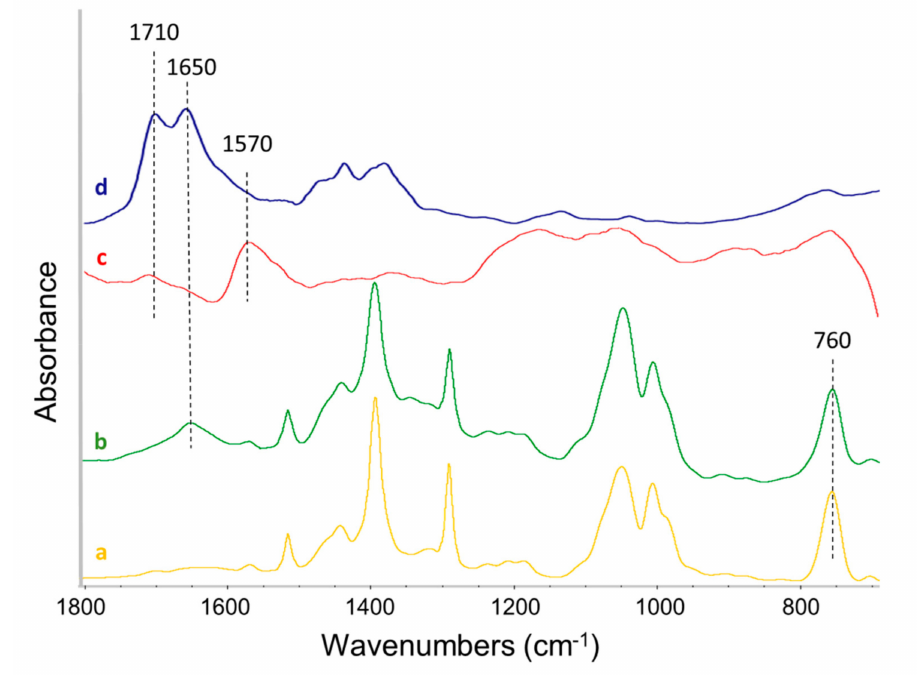
Figure 7. FT-IR spectra of: ( a ) SP, ( b ) SPO (1-(1,3-dihydroxypropan-2-yl)-5-methyl-1H-pyrrole- 2-carbaldehyde, SP with oxidized methyl groups), ( c ) CNT-SP, and ( d ) high surface area graphite (HSAG)-TMP fingerprint region 700–1900 cm − 1 after baseline correction. Spectra are displayed with normalized